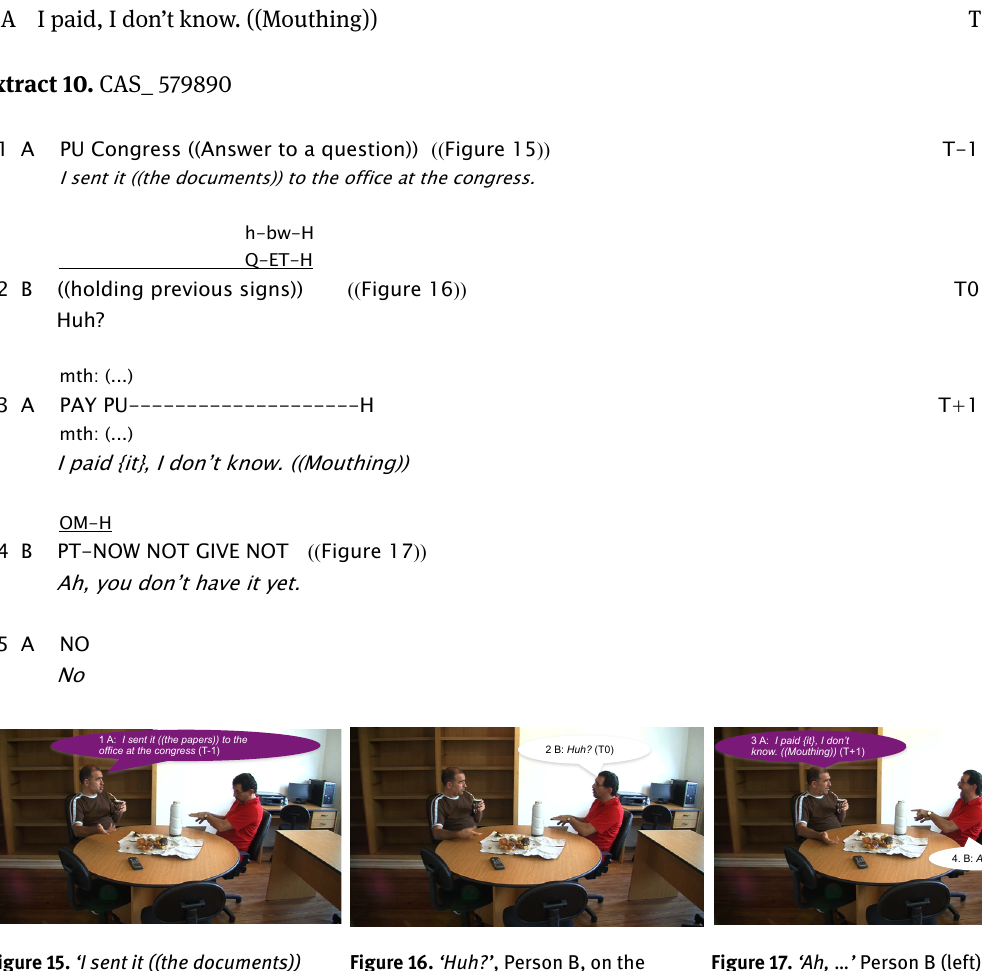
right, initiates repair on Person A’s previous turn by bringing his eyebrows together and raising his head-up, without retracting the end of the previ- ous sign, line 2 (T0).